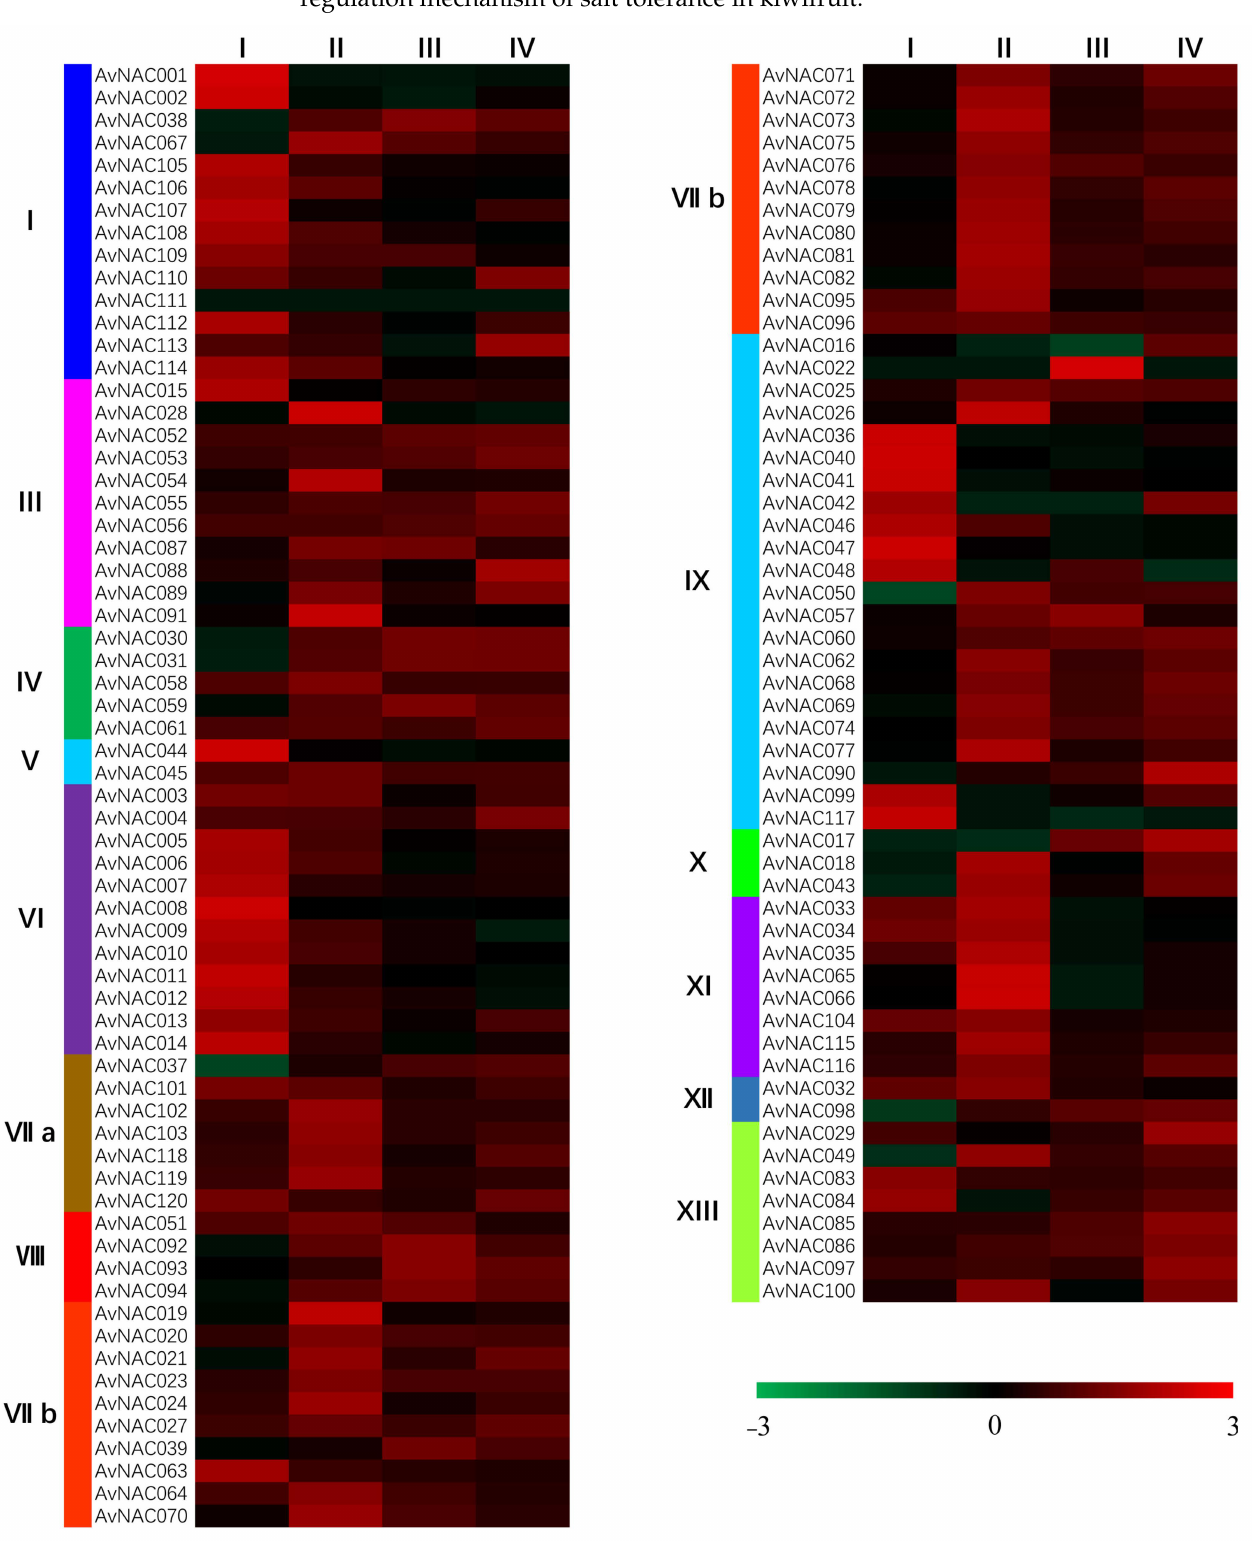
Figure 4. The heatmap of the NAC family at different time points after salt